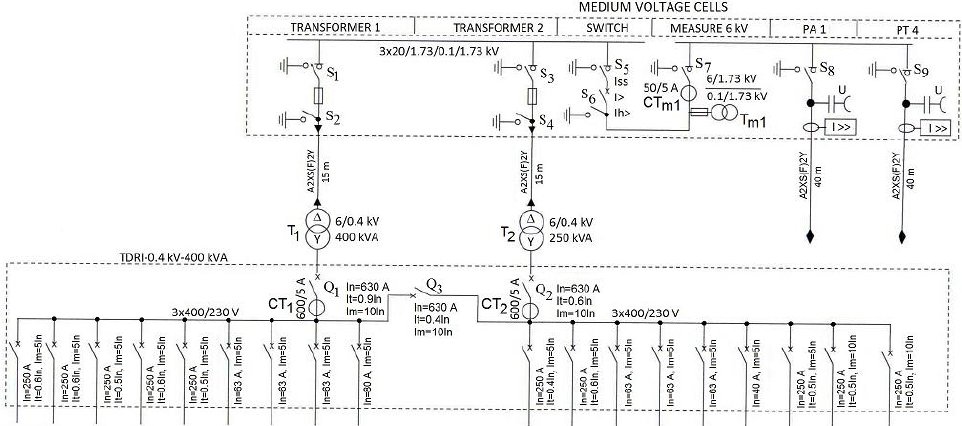
Figure 17. Wire electrical circuit diagram for residential and educational buildings.